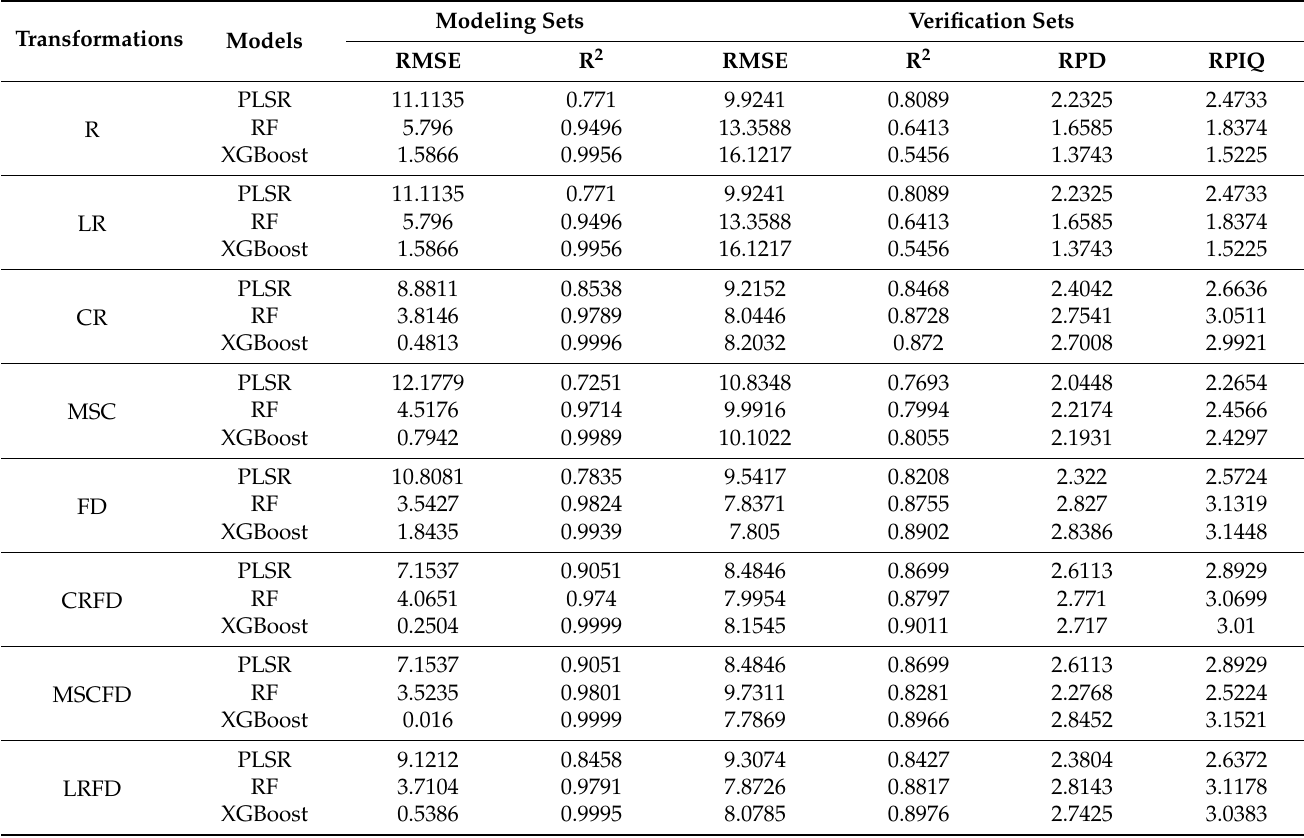
Table 4. SOC content simulation accuracy comparison based on different spectral transformations and